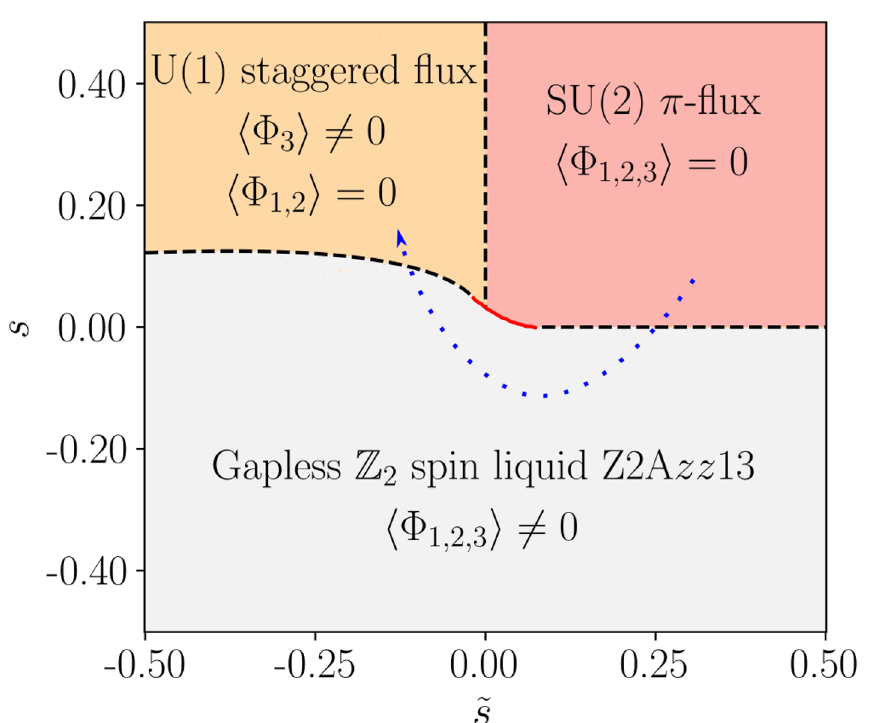
Figure 2 . Mean field phase diagram of our low energy theory obtained by minimization of the Higgs potential in eq. (2.7). Dashed (solid red) lines indicate second (first) order transitions in mean field theory. We assume the SU(2) π -flux gauge theory confines to a Néel state, the U(1) staggered flux gauge theory confines to a VBS state, except at their deconfined critical boundaries to Wen’s stable, gapless Z spin liquid Z2A zz 13 . The dotted blue line indicates a possible trajectory of the 2 square lattice antiferromagnet with increasing J . Figure adapted from 2 /J 1